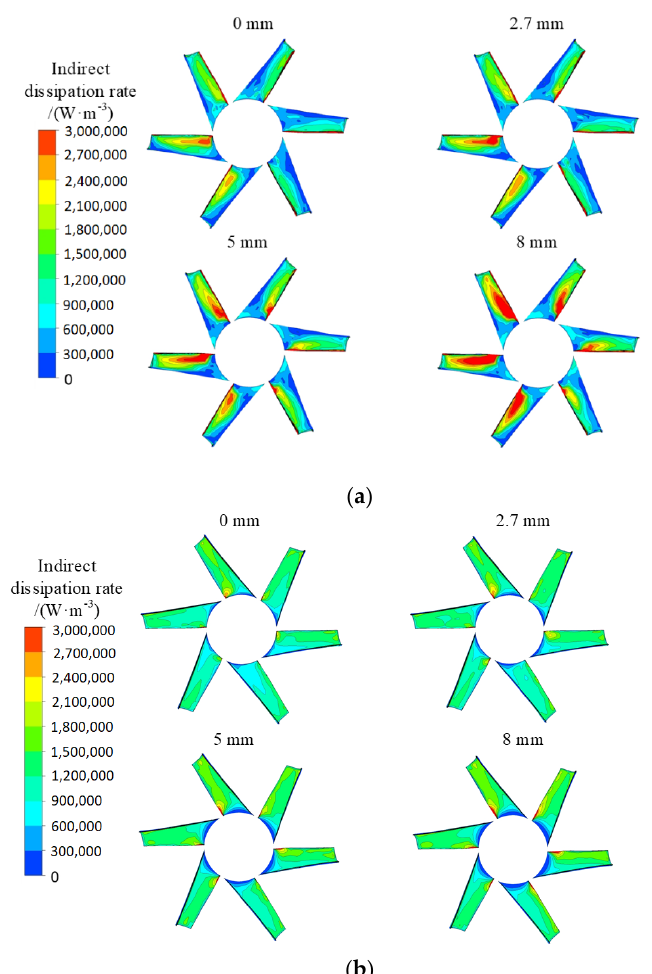
Figure 17. Distribution of indirect dissipation rate ( a ) from diffuser inlet and ( b ) from diffuser outlet on the surface of diffuser blades with varying root clearances ( R t = 0 mm, 2.7 mm, 5 mm, 8 mm; Q = 1.0 Q des ).